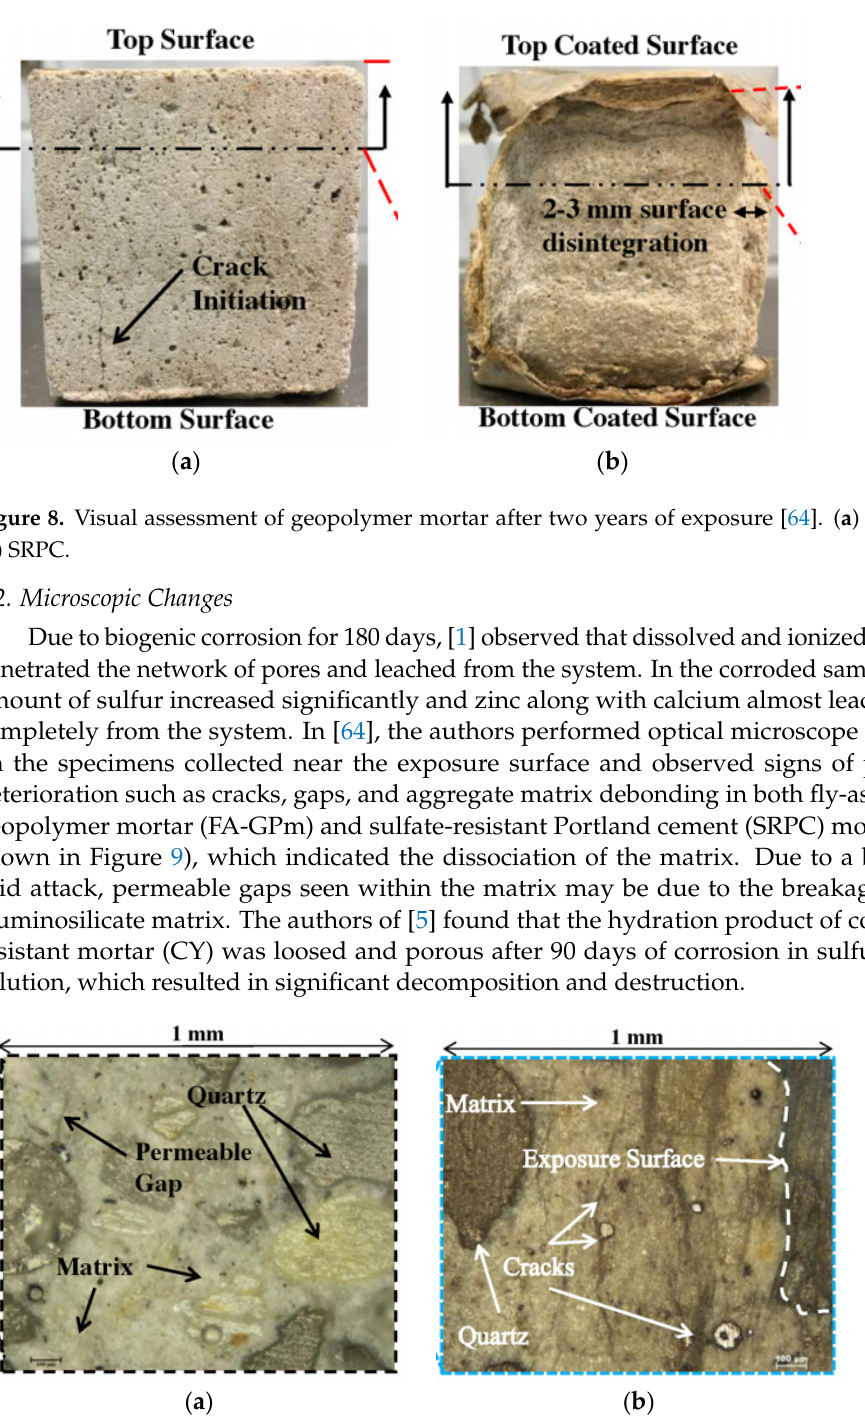
Figure 9. Optical microscopic image analysis of geopolymer after two years of exposure [64]. ( a ) FA- GPm ; ( b ) SRPC . GPm; ( b )